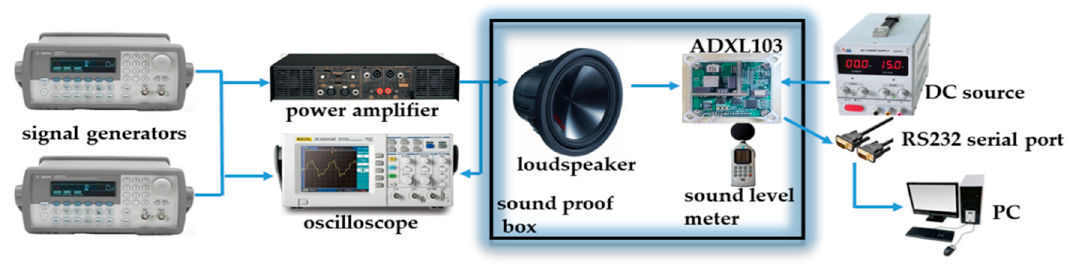
Figure 1. Acoustic injection; experimental facility.